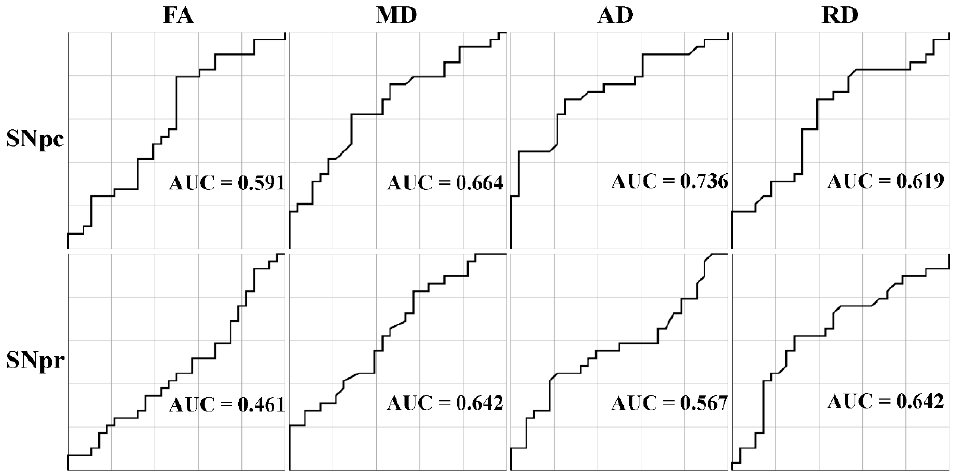
Figure 2. Receiver operating characteristic analysis in the substantia nigra. The top row shows the receiver operating characteristic (ROC) curves for the substantia nigra pars compacta (SNpc) while the bottom row shows ROC curves for the substantia nigra pars reticulata (SNpr). Legend: FA = fractional anisotropy; MD = mean diffusivity; AD = axial diffusivity ; RD = radial diffusivity; AUC = area under the curve. Table 3. Receiver operating characteristic curve analysis.